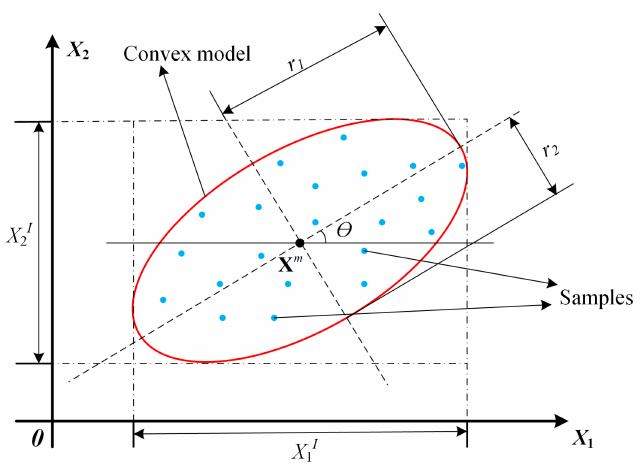
Figure 3. The uncertainty domain of two-dimensional ellipse in the convex model